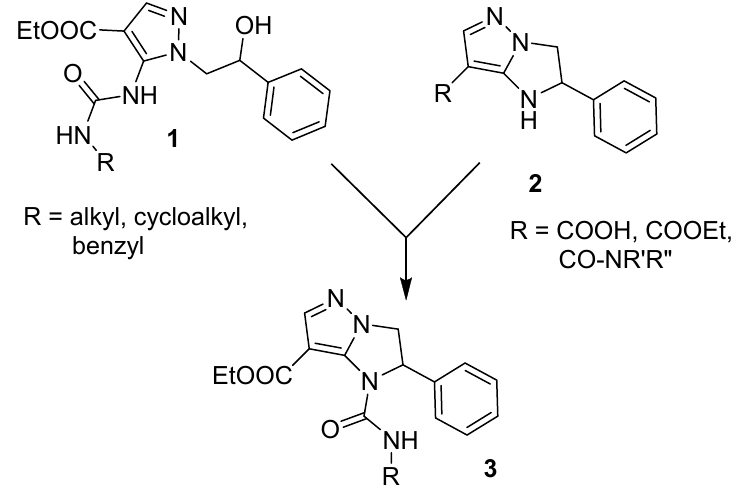
Figure 1. General structure of chemotaxis inhibitors 1 , 2 , 3 .